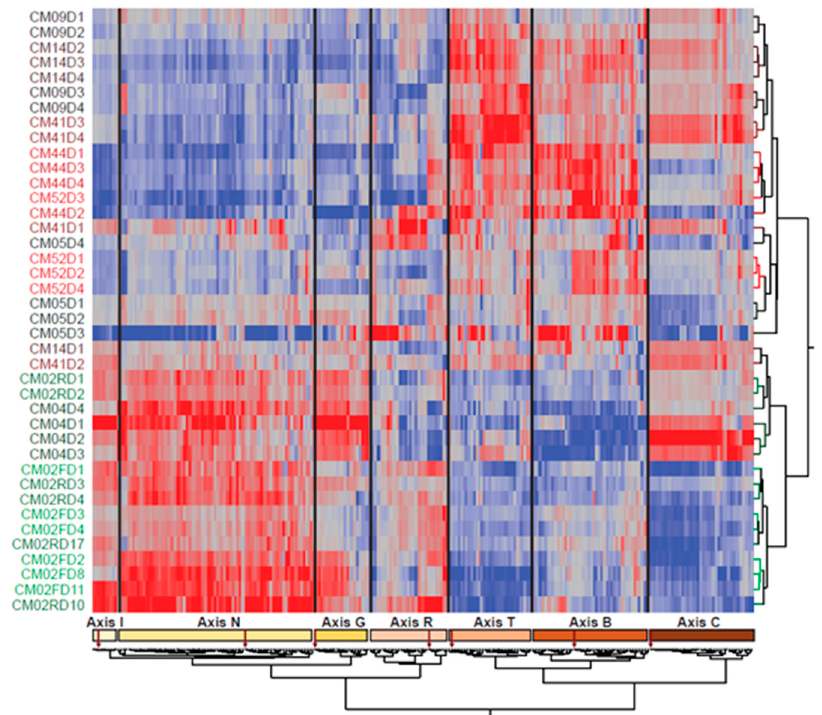
Figure 1. Two-way hierarchical clustering of blood transcript modules (BTM) and blood informative transcripts (BIT) by individual and time. Each row represents one patient on the day indicated by the last number of the label, and each column is the principal component (PC1) score for a BTM, with co-clustered BIT PC1 highlighted. The red-to-blue scale indicates positive to negative scores. The figure highlights the tendency of the samples to cluster by individual and provides an overview of the axes of variation shared by particular patients.